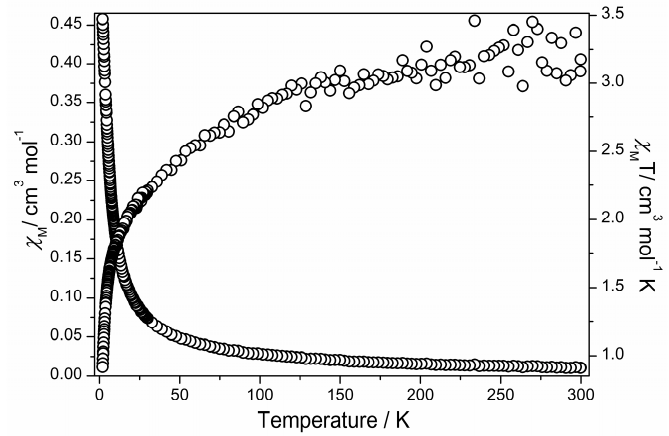
Figure 10. χ M and χ M T as a function of the temperature for 5 at H DC = 1000 Oe.